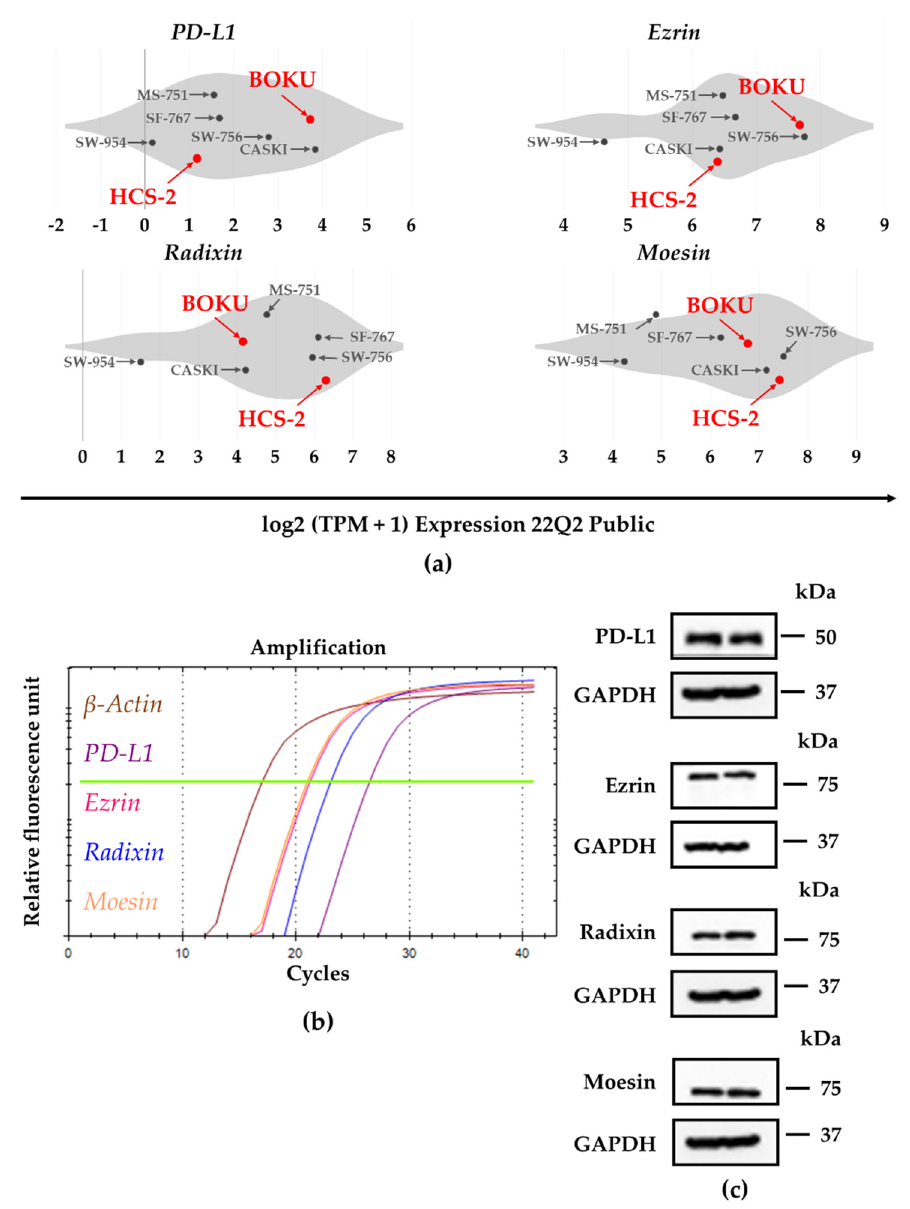
Figure 1. Gene and protein expression profiles of programmed death ligand-1 (PD-L1), ezrin, radixin, and moesin (ERM) in the human uterine cervical squamous cancer cells. ( a ) Violin plots showing the median gene expression (log2 (TPM +1)) of PD-L1 and the ERM family members in various human uterine cervical squamous cancer cell lines evaluated by utilizing the Cancer Dependency Map (DepMap), Broad (2022): DepMap 22Q1 Public. ( b ) Representative amplification curves for PD-L1, ezrin, radixin, and moesin as well as β -actin, indicating relative mRNA expression in BOKU cells as determined by real-time reverse transcription polymerase chain reaction (RT-PCR). ( c ) Representative western blot images for PD-L1, ezrin, radixin, moesin, and glyceraldehyde-3-phosphate dehydrogenase (GAPDH), indicating protein levels in whole-cell lysates of BOKU cells. Molecular weights are denoted in kDa. The data are representative of three independent experiments using at least three independent samples of total RNA and protein extracts.